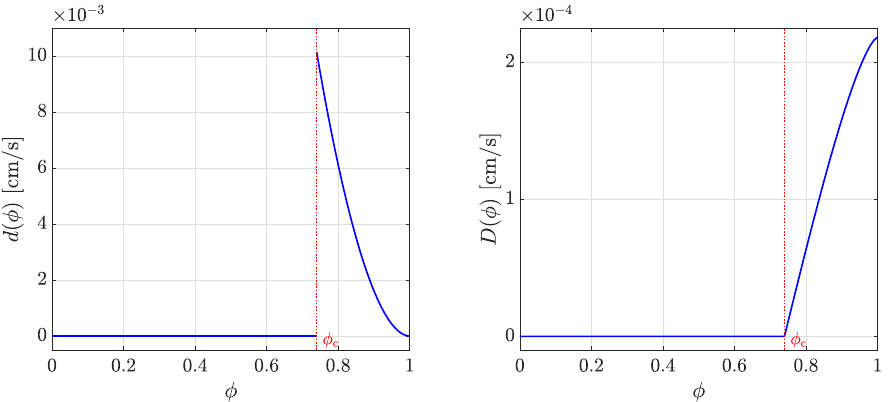
Figure 5. Functions d ( φ ) ( left ) and D ( φ ) ( right ) modelling the capillarity. In both figures, we set φ c =